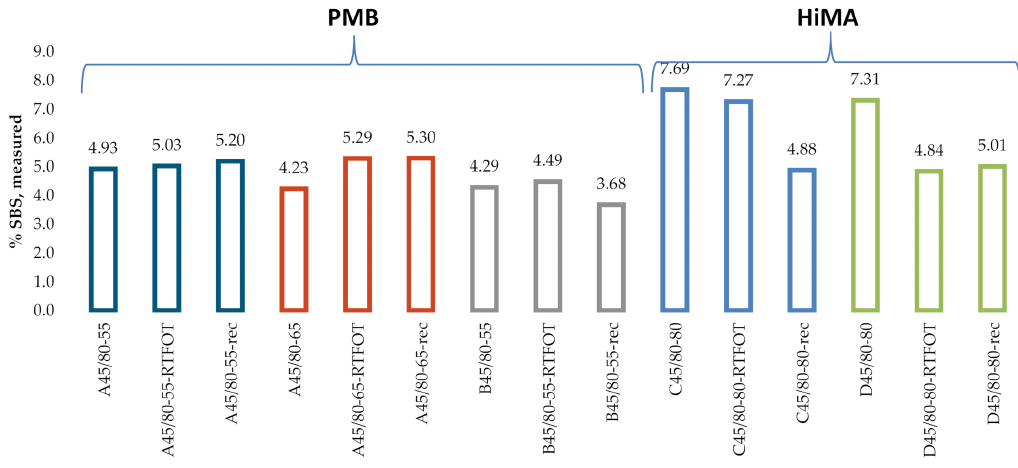
Figure 16. SBS contents measured on industrial